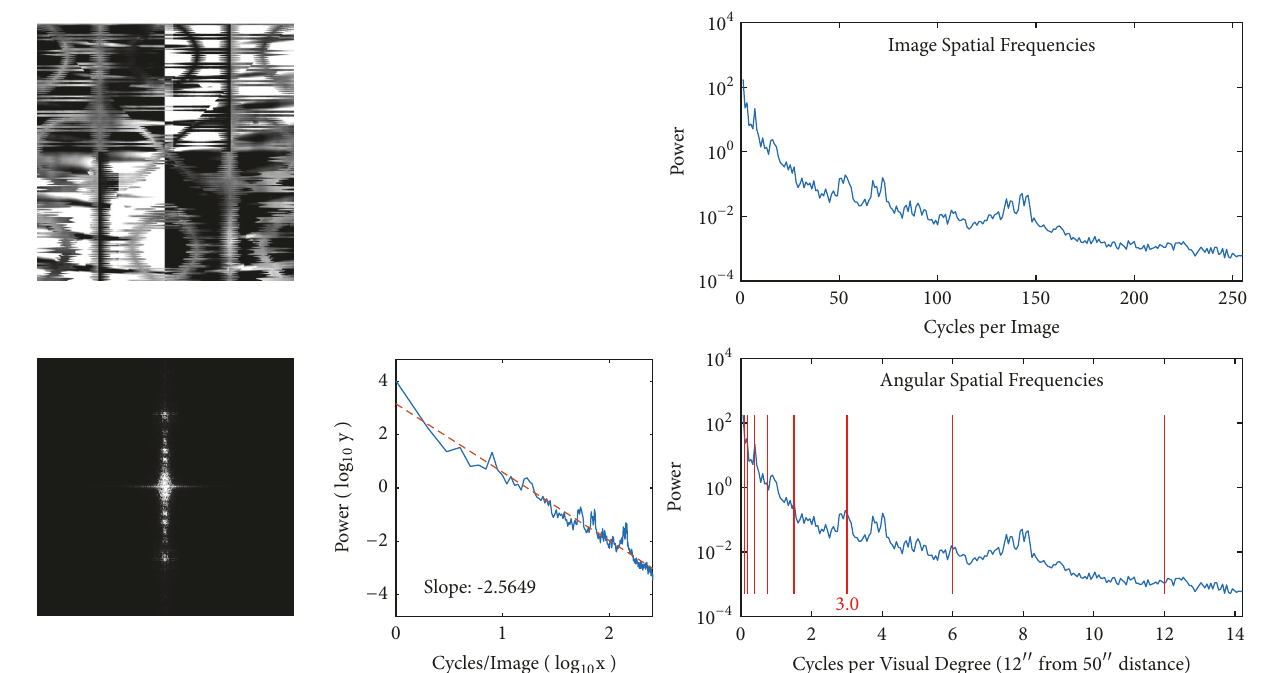
Figure 18: Angular spatial frequency analysis, distance variations. At the top left we have the analysed image, beneath which there are power spectra coefficients display and radially averaged power spectra. The top right graph plots power of the absolute spatial frequencies relative to image width, below which there are the spatial frequencies calculated relative to visual angle at a specific viewing distance. As recommended by Fernandez and Wilkins [3], octaves about 3 cycles/degree have been